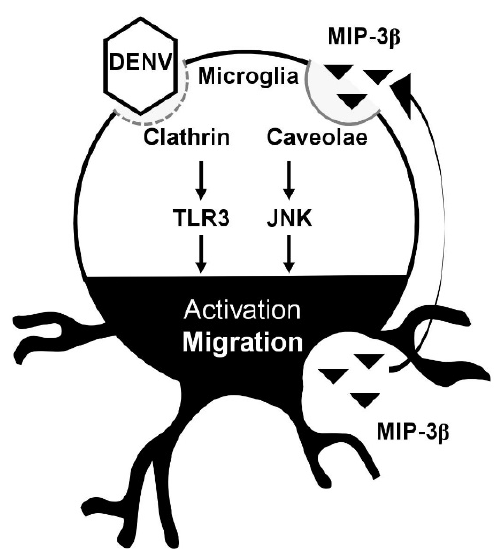
Figure 5. A hypothetical model of DENV-induced microglial cell migration. Secreted chemotactic factors in DENV-infected microglia facilitate cell motility. Pharmacologically disrupting lipid rafts/caveolae reduces microglial cell migration. MIP-3 β is secreted from DENV-infected microglia. Targeting JNK retards microglial cell migration.